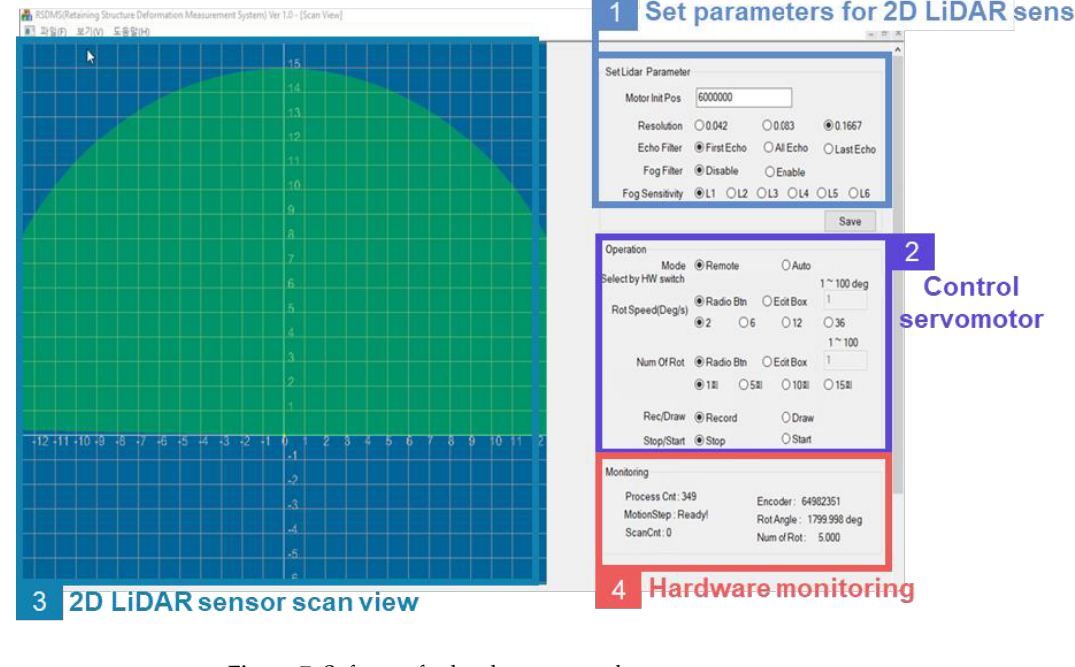
Figure 7. Software for hardware control.